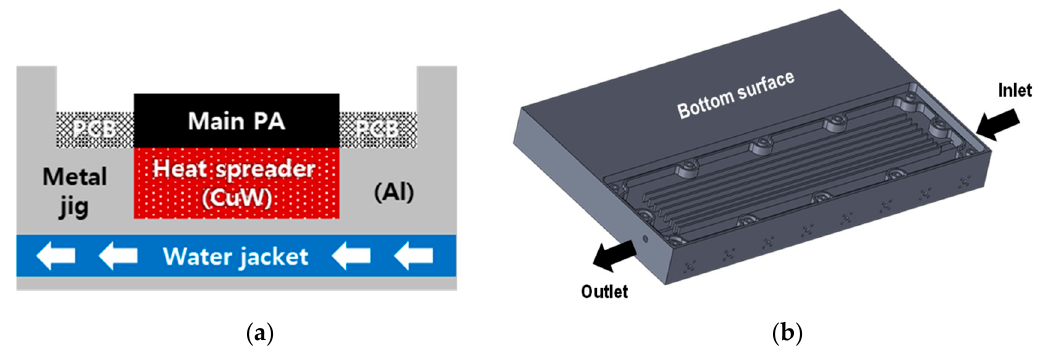
Figure 5. Cooling method consideration of the proposed module ( a ) the cross-sectional view of heat spreader implementation ( b ) the 3-D model of water jacket implementation at bottom.